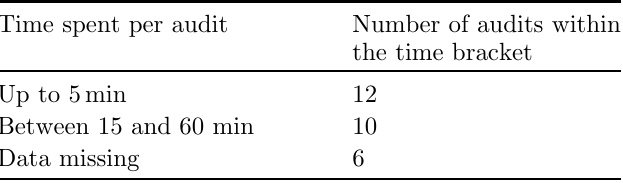
Table 4. Time spent to backtrack presented data to raw